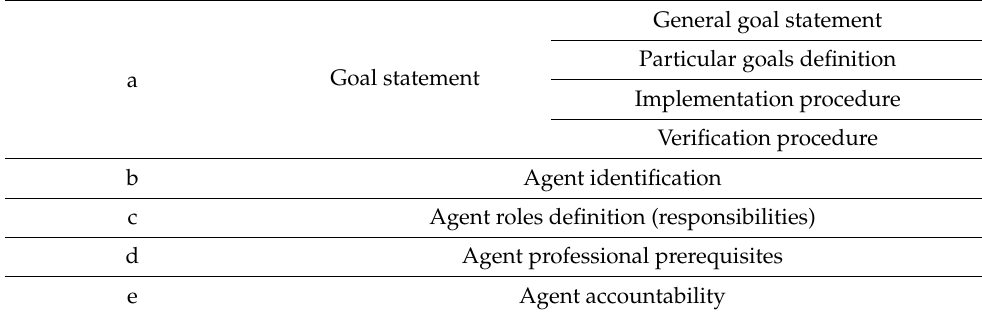
Table 2. Basic components of a building regulatory regime (elaborated by the